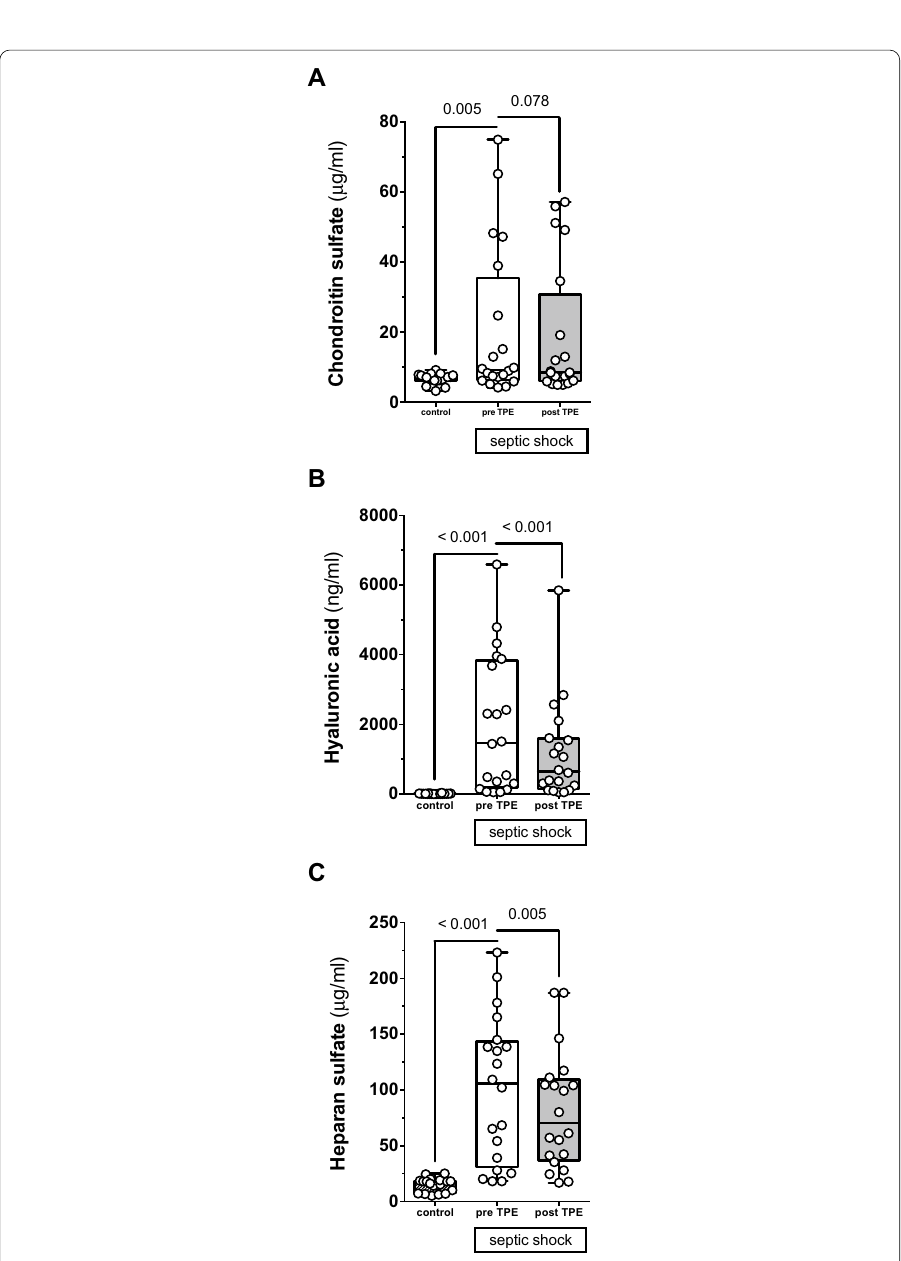
20) and directly =